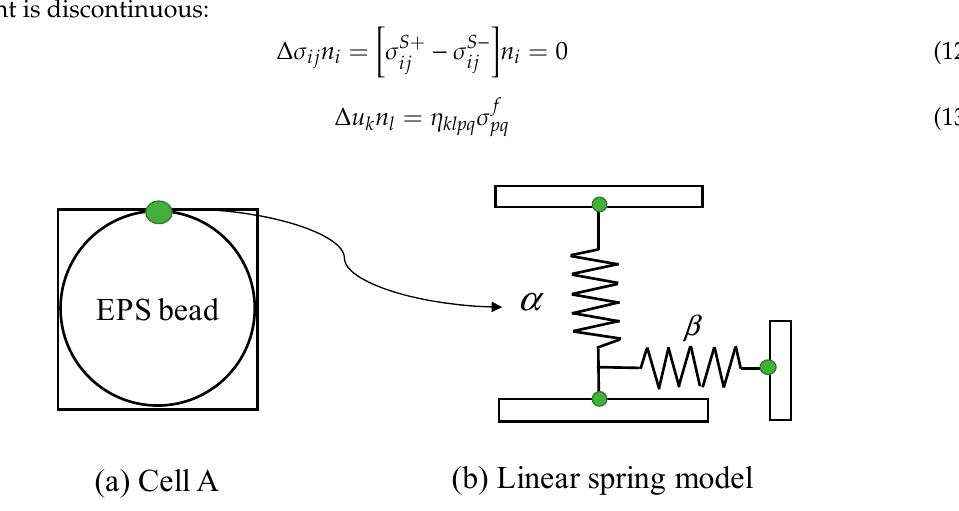
Figure 4. An imperfect interface simplification model.